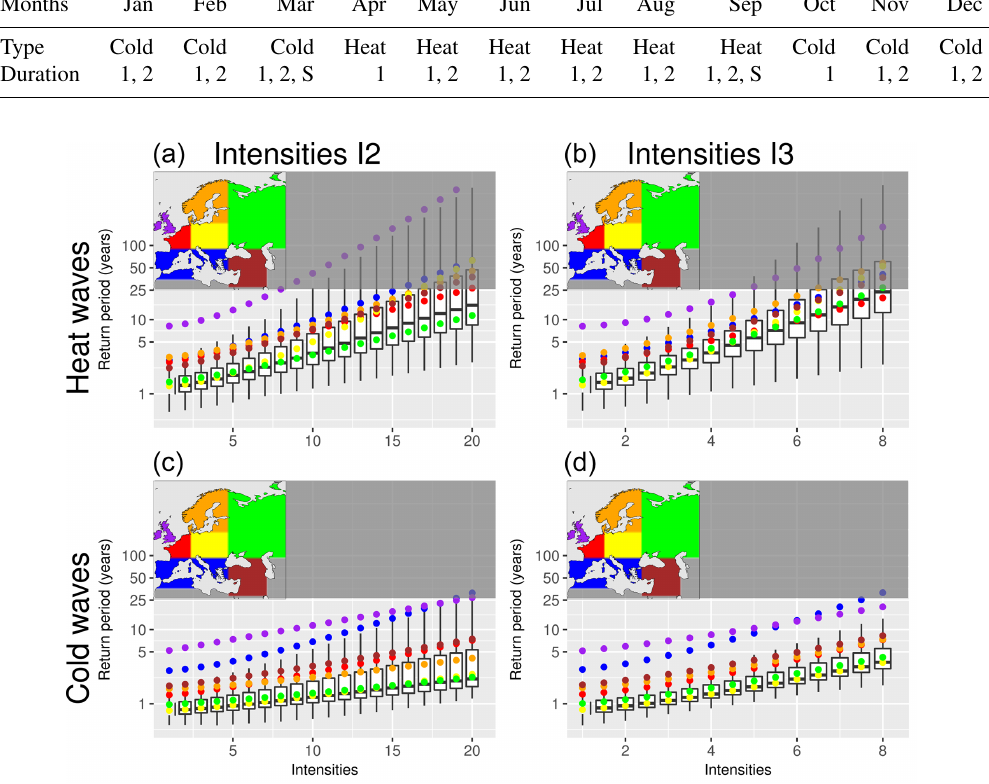
Figure 11. Return periods of monthly intensities of heat (a, b) and cold (c, d) waves for two intensities (I2, a , c , and I3, b , d ). Boxes assess the spatial variability for the grid points. Coloured dots indicate the return period calculated over the regions defined in the small